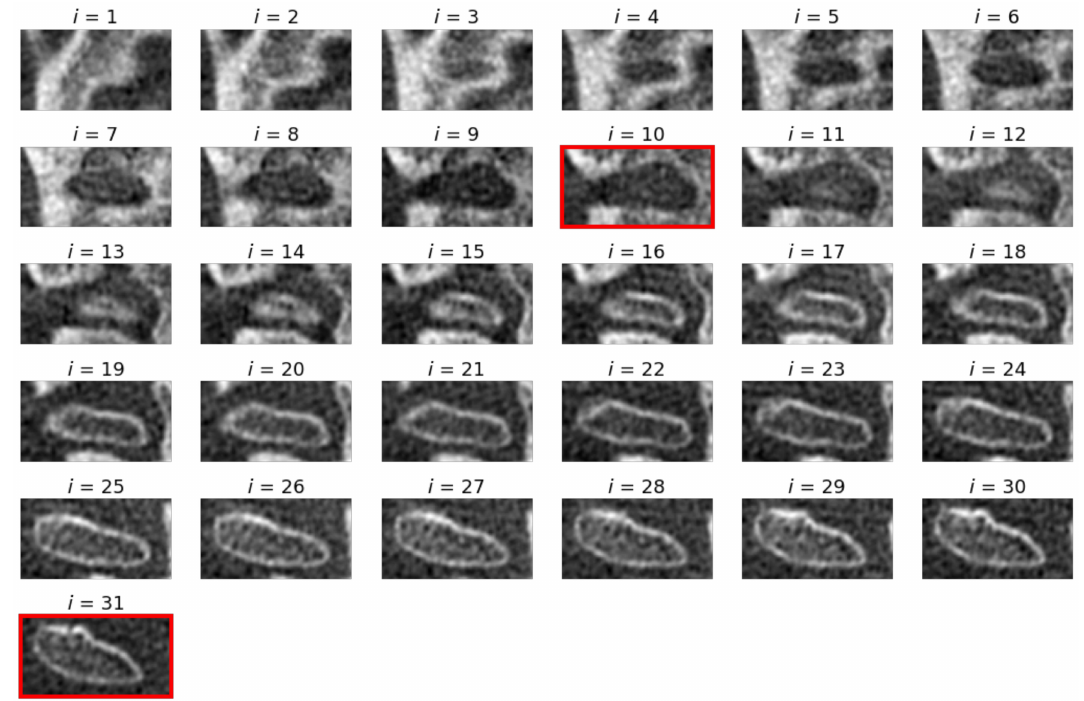
Figure 9. The consecutive slices of input scan restricted to VOI. The first and last slices with identified TMJ head bone tissue are marked with red frames.